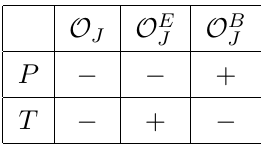
Table 1 . Parity and time reversal properties of j = 1 composite